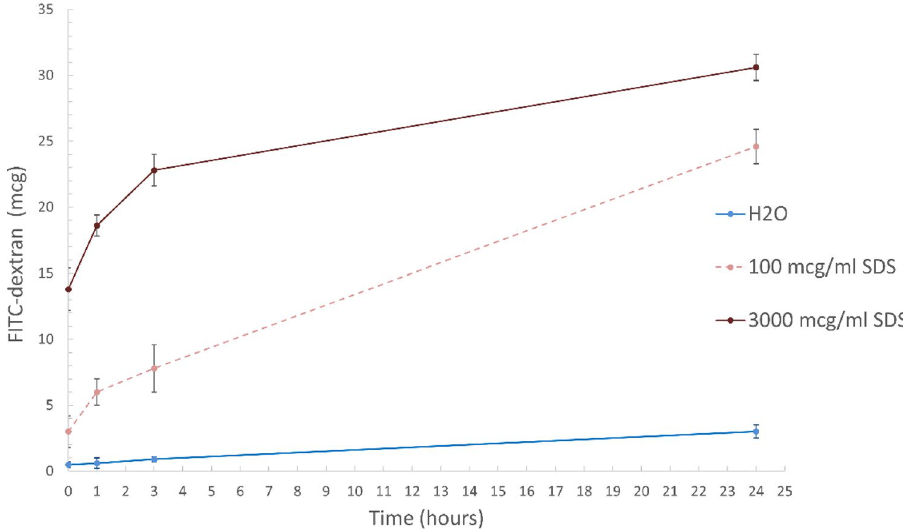
Figure 5. The release of FITC-dextran over time from polyelectrolyte microcapsules in SDS solution (100 and 3000